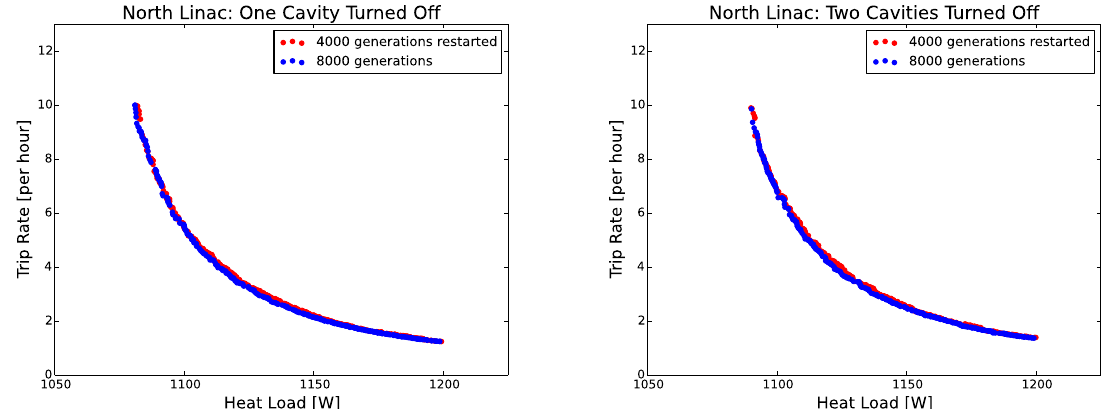
FIG. 4. Effect on turning off one cavity (left panel) or two cavities (right panel) and restarting the simulation from the previous solution with all cavities on. The blue points denote the Pareto-optimal front produced by 8000 generations of the GA simulation started from a random sampling of the search space, and the red points show the 4000 generations of the GA simulation restarted from the solution to the full cavity problem with 4000